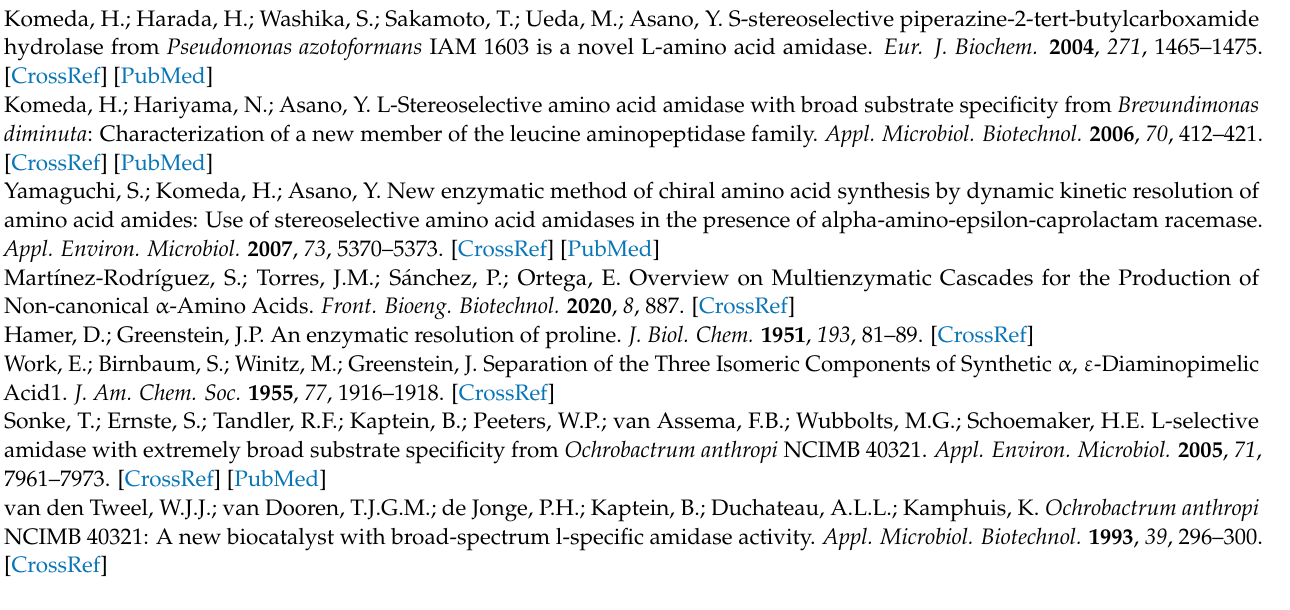
L-amidase activity. Figure S3: Surface representation of different peptidase S33 family members. Figure S4: Comparison of the polyketide substrate binding site of VinJ with that of APF1, MysPAP, and PsyPAH. Figure S5: Omit maps calculated for the PsyPAH structure. Table S1: Homolog structures of PsyPAH obtained with the DALI server. Table S2: Different ligand-bound structures of Tricorn Interacting Factor F1. Table S3: Residues involved in substrate binding and catalysis in the different pockets of APF1. Table S4: Comparison of residues proposed in the polyketide binding tunnel in